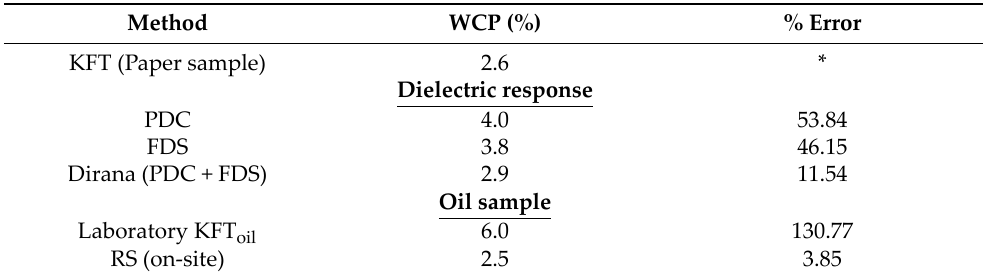
Table 9. Percentage error comparison of different water content detection methods. (Direct KFT paper detection as